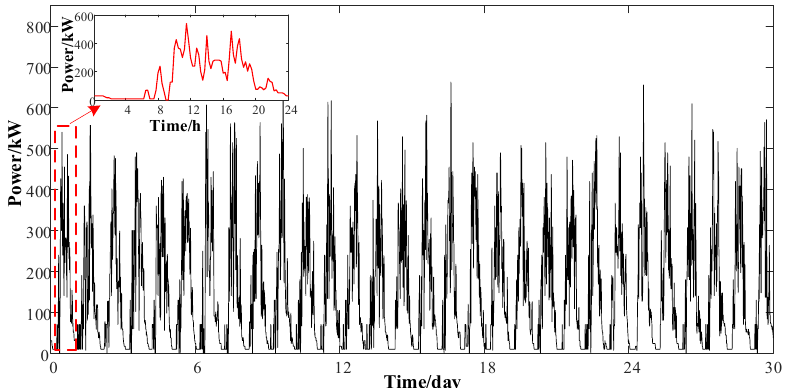
Figure 3. Monthly charging load curve for 140 electric vehicles.